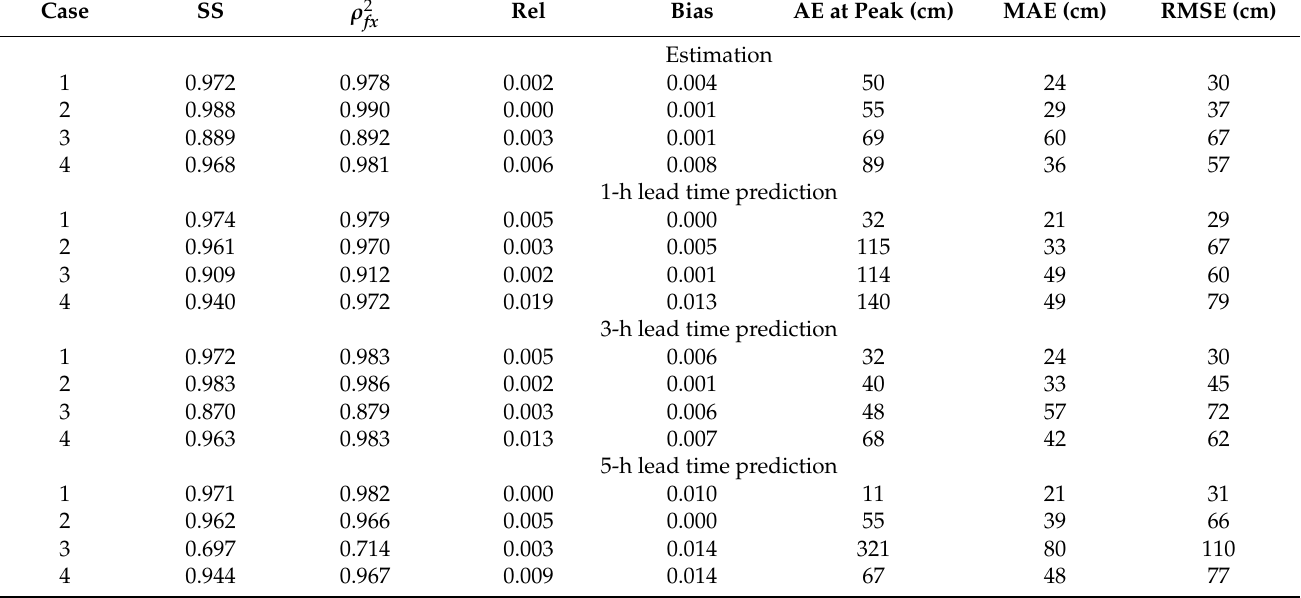
Table 2. Evaluation measures of the four flood events in the test dataset. All the measures except for AE at peak were calculated within 24 h of the peak level. The standard deviations of observed stages during the 48 h are 181, 339, 200, and 323 cm for cases 1, 2, 3, and 4,